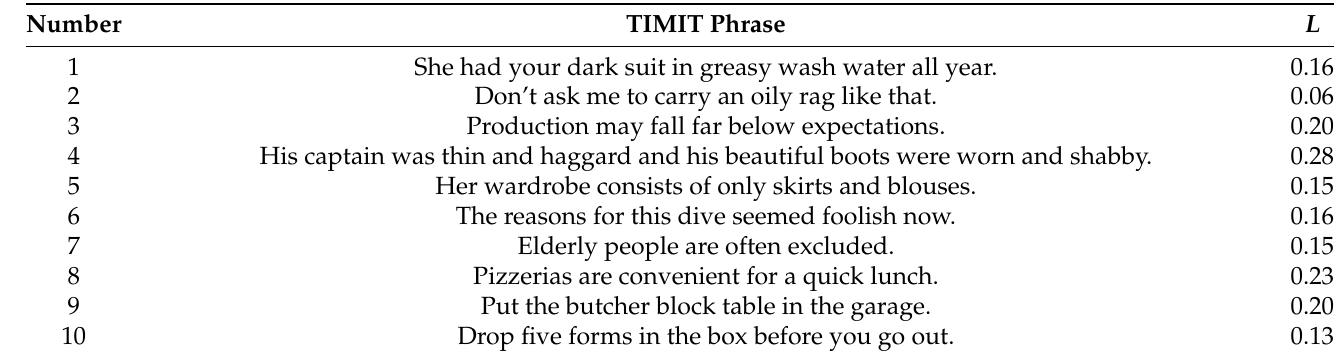
Table 3. Examples of Levenstein distance between the reference transcription of TIMIT and the one obtained by DSPCore transcription module.